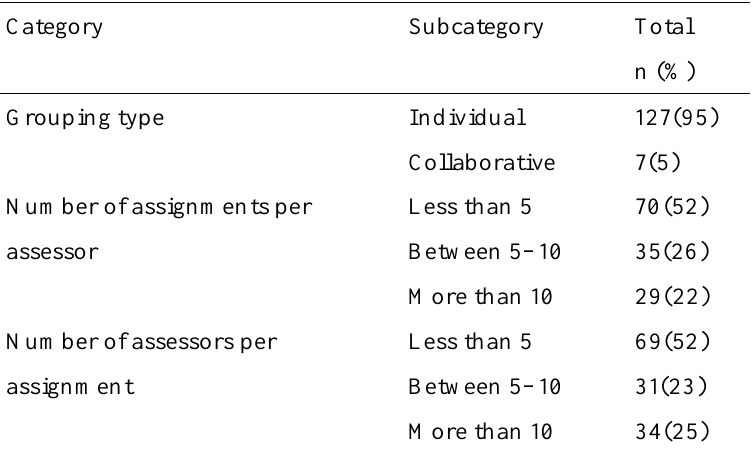
Descriptive Data for the Division of